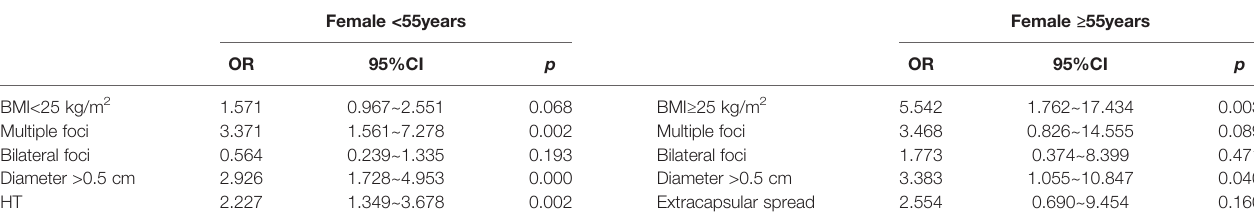
TABLE 4 | Multivariate logistic regression analyses to identify independent affecting risk factors of PTMC combined with lymph node metastasis in female of different age